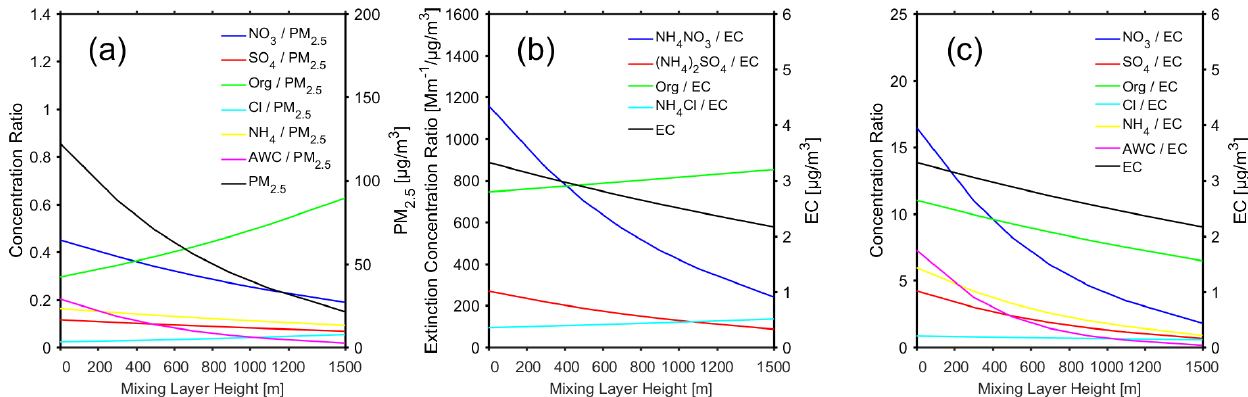
Figure 8. (a) The ratio of the mass concentration of different chemical components (nitrate, sulfate, organics, chlorine, ammonium) and AWC to the mass concentration of NR_PM 2 . 5 as a function of MLH. (b) The ratio of dry aerosol light extinction by different chemical components (NH 4 NO 3 , (NH 4 ) 2 SO 4 , Org, NH 4 Cl) to the mass concentration EC as a function of MLH. (c) The ratio of the mass concentration of different chemical components (nitrate, sulfate, organics, chlorine, ammonium) and AWC to the mass concentration of EC as a function of MLH. All the data correspond to polluted conditions (fine PM > 75µgm − 3 ), and only daytime conditions determined by the ceilometer from non-rainy periods (RH < 95%) were